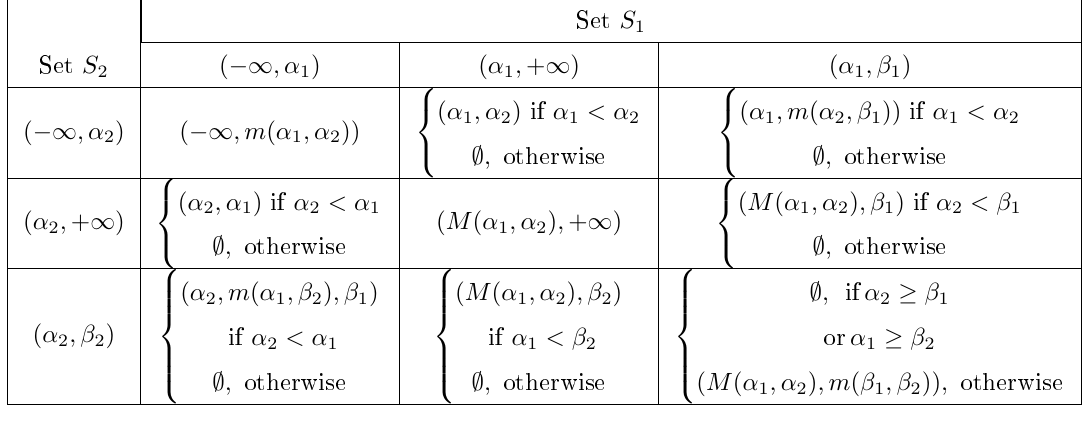
Table 3. Selected plants.